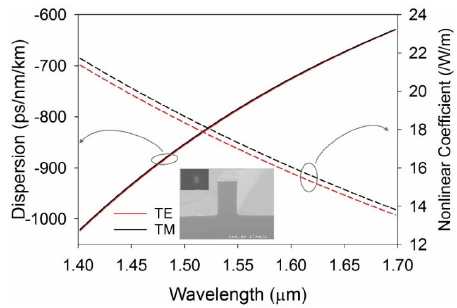
Figure 11. Dispersion and nonlinear coefficient curves for the structure under investigation as a function of wavelength. Inset: Scanning Electron Microscope (SEM) image of the 1 μ m wide SiGe strip waveguide before and after encapsulation in a 12 μ m Si cladding layer [27].